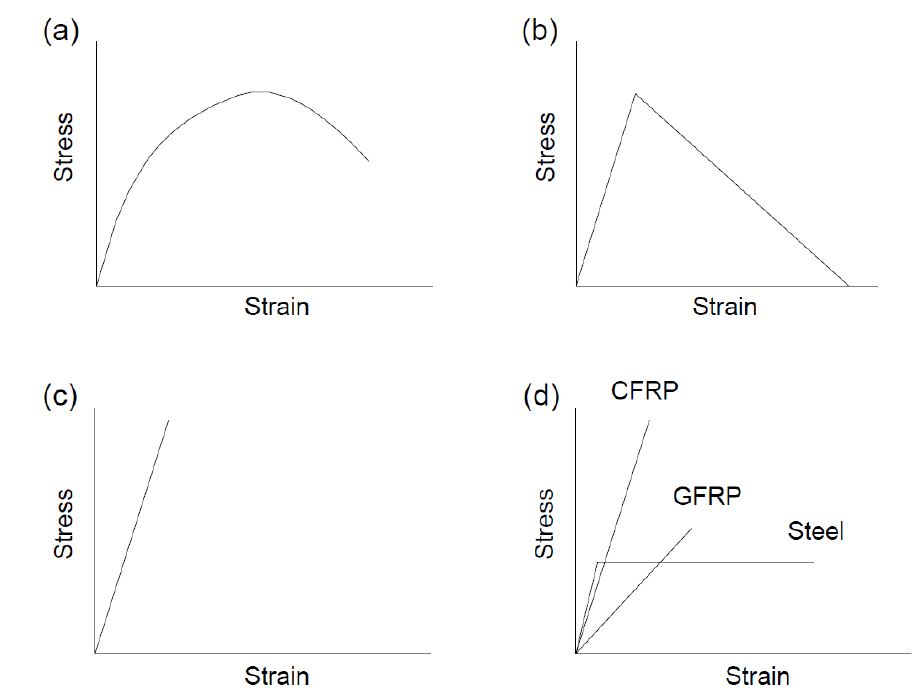
Figure 2. Stress–strain curves of materials. ( a ) concrete in compression recommended in Eurocode 2 [32]; ( b ) concrete in tension; ( c ) Fiber-reinforced polymer (FRP) tendons; ( d ) FRP and steel rebars.